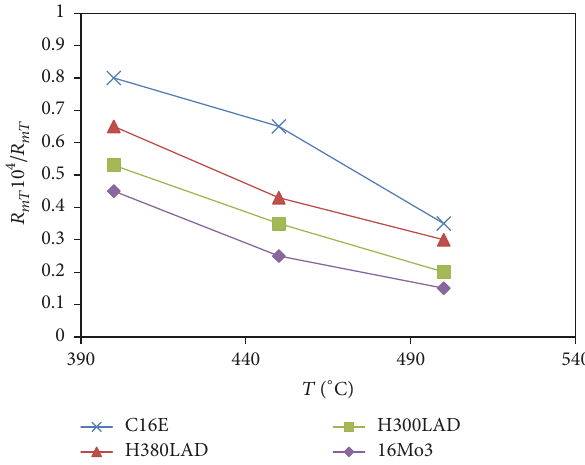
Figure 3: Dependence of the time to fracture ( 𝑡 𝑓 ) on the nominal stress ( 𝑅 𝑜 ) for H380LAD steel.